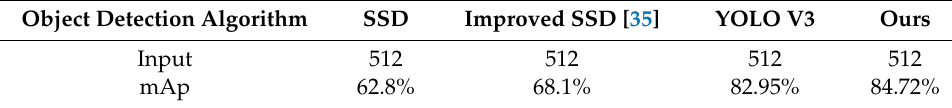
Table 6. Results of each algorithm on the KITTI dataset.